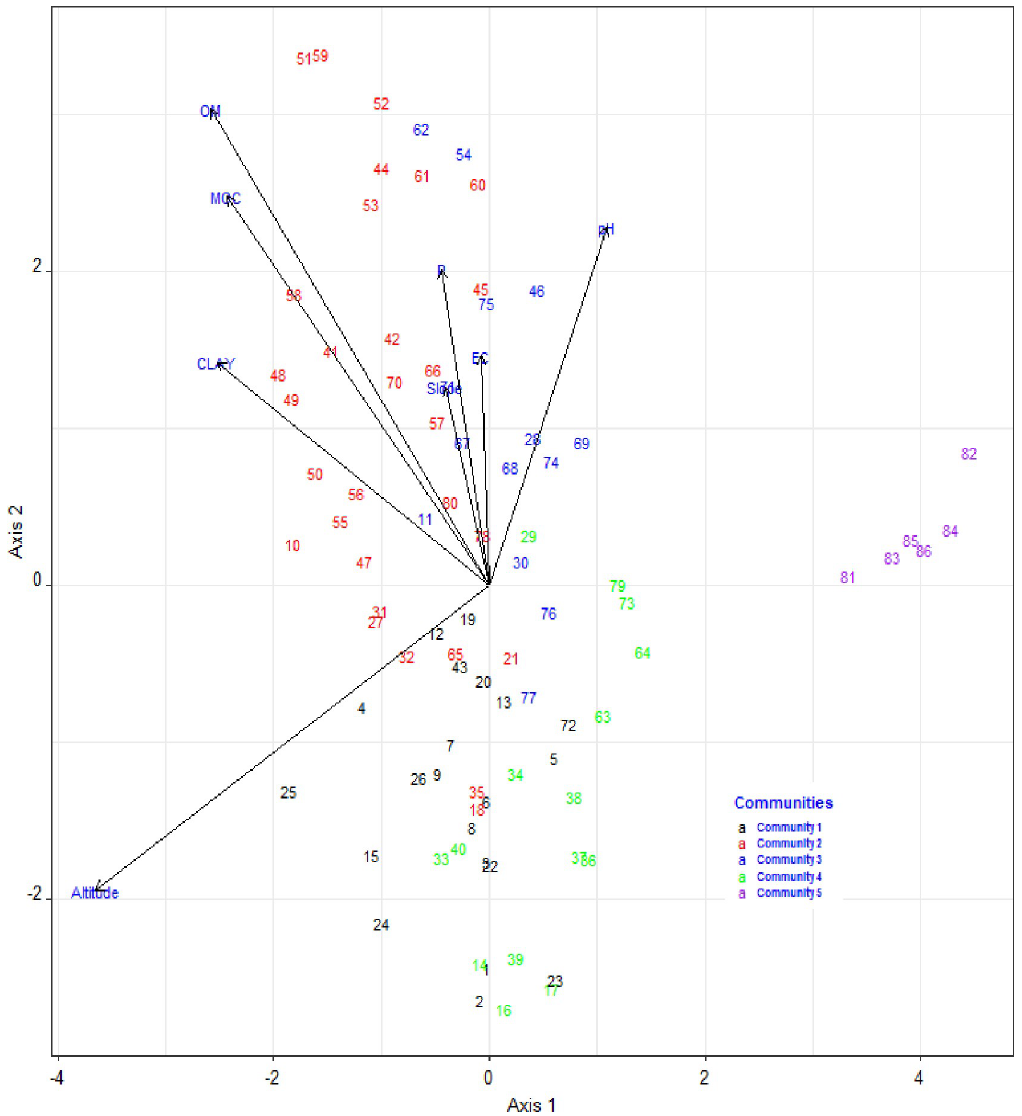
Fig 4. Redundancy analysis (RDA) ordination graph significant environmental variables (p < 0.05) and the plant community in the study area. The arrows in the diagram stand for the environmental factors, the length of each arrow indicates the contribution of the factor to ordination axes, The numbers refer to quadrat number, and the angle between the arrows and he axes indicates the correlation between the variable and the ordination